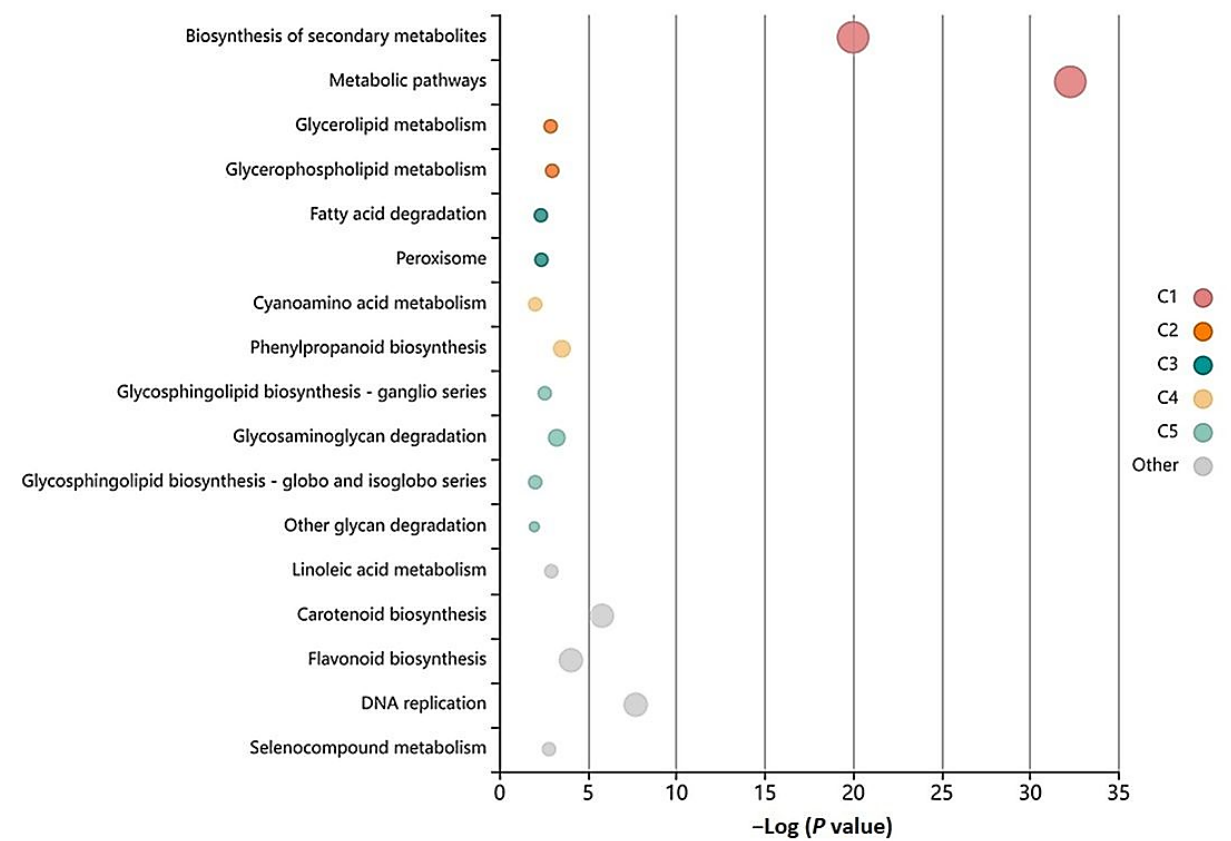
Figure 4. Bubble plot showing KEGG enriched terms for lentil genotype Precoz when infected with Rhizoctonia where each bubble represents an enriched function and the size of the bubble from small to large represents their relative abundance. The color of the bubble is the same as the color in the network, which represents a different cluster. For each cluster, if there are more than five terms, the top five with highest enrich ratio are displayed. Table 3. PHIBase analysis of DEGs identified in response to fungus infection in